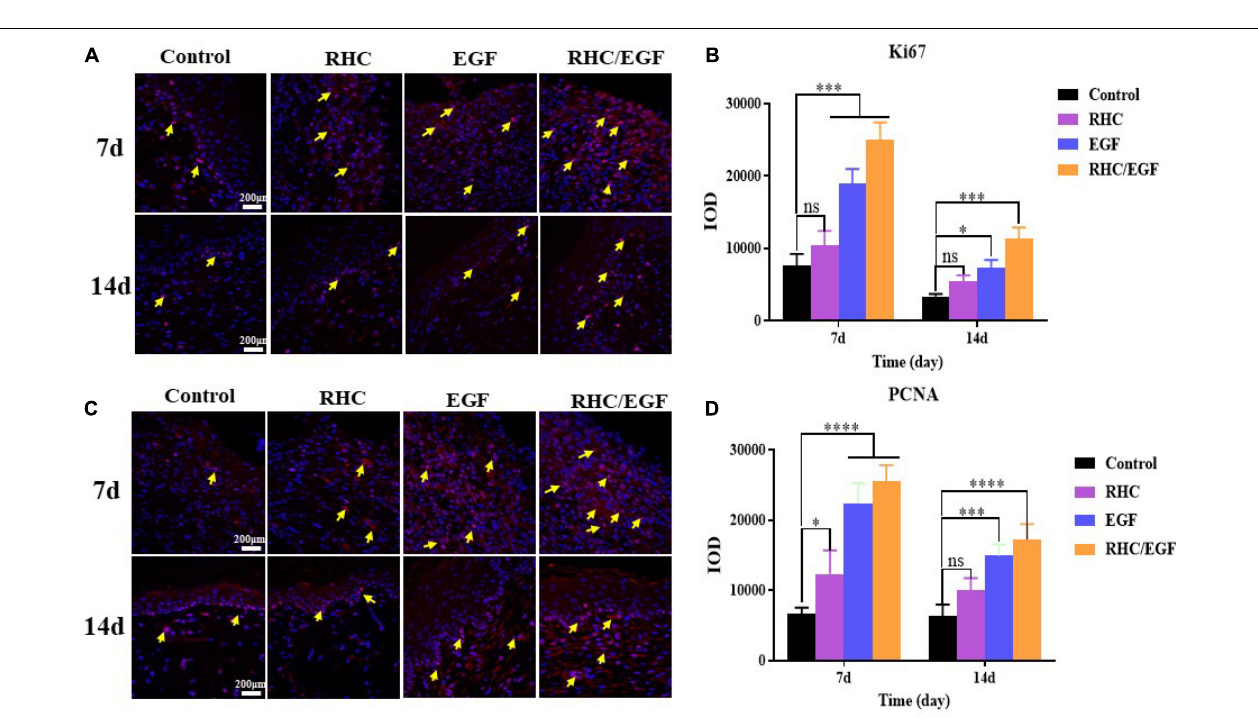
FIGURE 4 | Experimental study of rat wound-healing model after treatment with physiological saline, RHC, EGF, or RHC/EGF. (A) Wounds were photographed at days 0, 3, 5, 7, 10, 14, and 21. (B) Quantitative analysis of epithelial thickness at days 14 and 21 using ImageJ software. (C) Hematoxylin and eosin staining of rat wound-healing model after treatment for 3, 14, and 21 days. (D) Quantitative analysis of wound closure rate. (E) Masson trichrome staining of rat wound-healing model after treatment for 7 and 21 days. n = 5, means ± SD, **P < 0.01 vs. control group, ns means no significant difference vs. control group, P > 0.05.